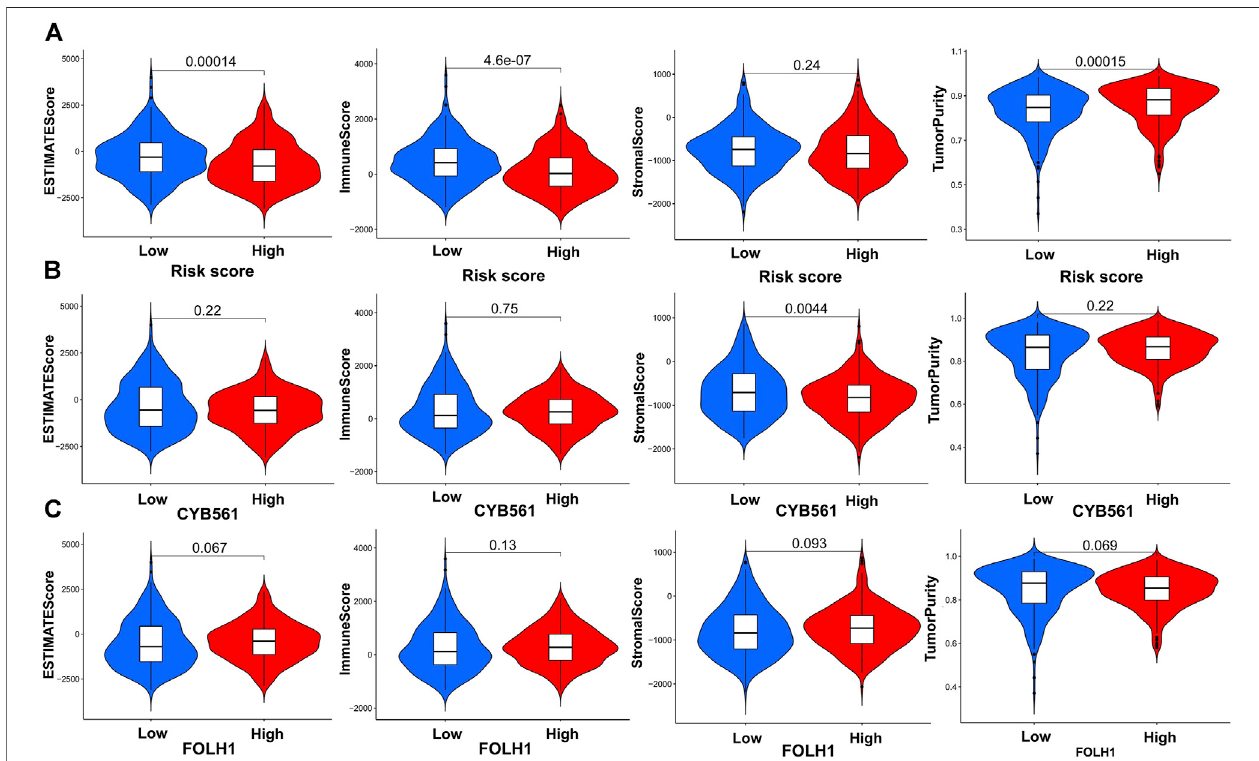
FIGURE 9 | Construction and veri fi cation of the immune-related UCEC subgroups. (A) The violin plot shows the differences in Tumor Purity, ESTIMATE Score, Immune Score, and Stromal Score between the high- and low-risk score groups, calculated using the ESTIMATE algorithm. Comparison of Stromal Scores, Immune Scores, ESTIMATE Scores, and Tumor Purity between two groups of CYB561 (B) and FOLH1 (C) .